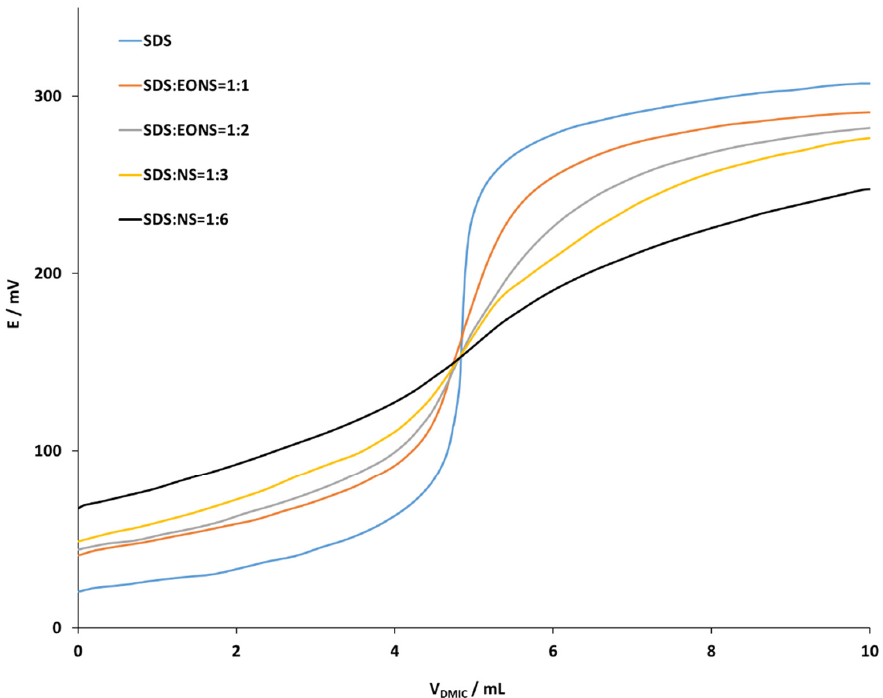
Figure 4. Potentiometric titration curves for titration of mixtures with different molar ratio of SDS (4 × 10 − 3 M) and 10 EO EONS using DMIC (4 × 10 − 3 M) as a titrant and a DHBI–TPB surfactant sensor as an end-point indicator. The titration curves are rearranged for the sake of clarity in the following order: SDS:EONS ratio 1:0 (blue line), 1:1 (red line), 1:2 (grey line), 1:3 (yellow line) and 1:6 (black line).